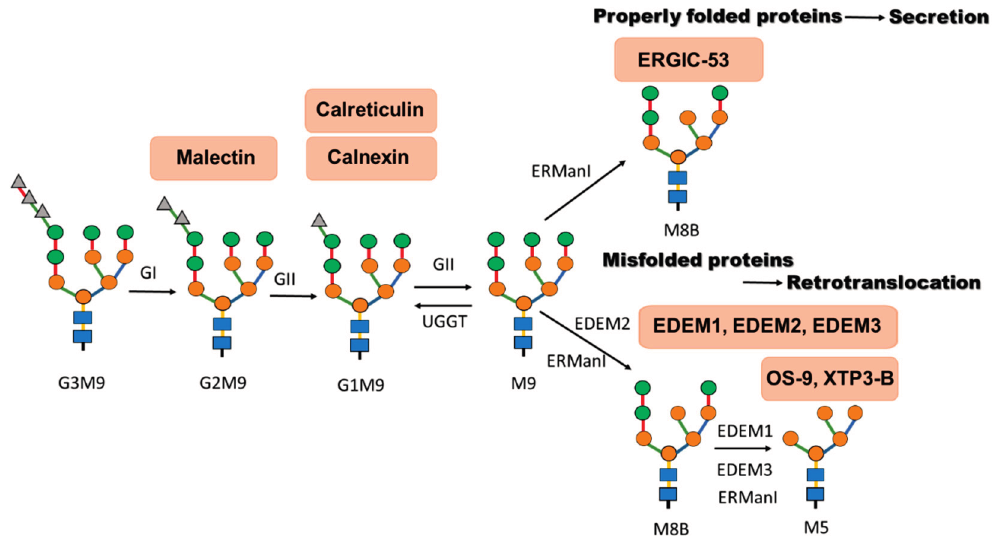
Figure 2. Glycan processing determines the fate of folding-competent and folding-defective glycoproteins. Nascent chains are glycosylated by addition of the 14 subunit oligosaccharide core (see Figure 1). After cleavage of the first glucose residue, di-glucosylated polypeptides (G2M9) associate with malectin. α -glucosidase II (GII) removes the second glucose, generating mono-glucosylated polypeptides (G1M9), which enter calnexin/calreticulin cycle. Once released from calnexin or calreticulin, glycoproteins are deglucosylated (M9) by glucosidase II. Re-glucosylation by UDP-glucose:glycoprotein glucosyltransferase (UGGT) enables the re-association of the polypeptides with calnexin or calreticulin. ER mannosidase I (ERManI) removes one mannose residue, generating eight mannose residues polypeptide